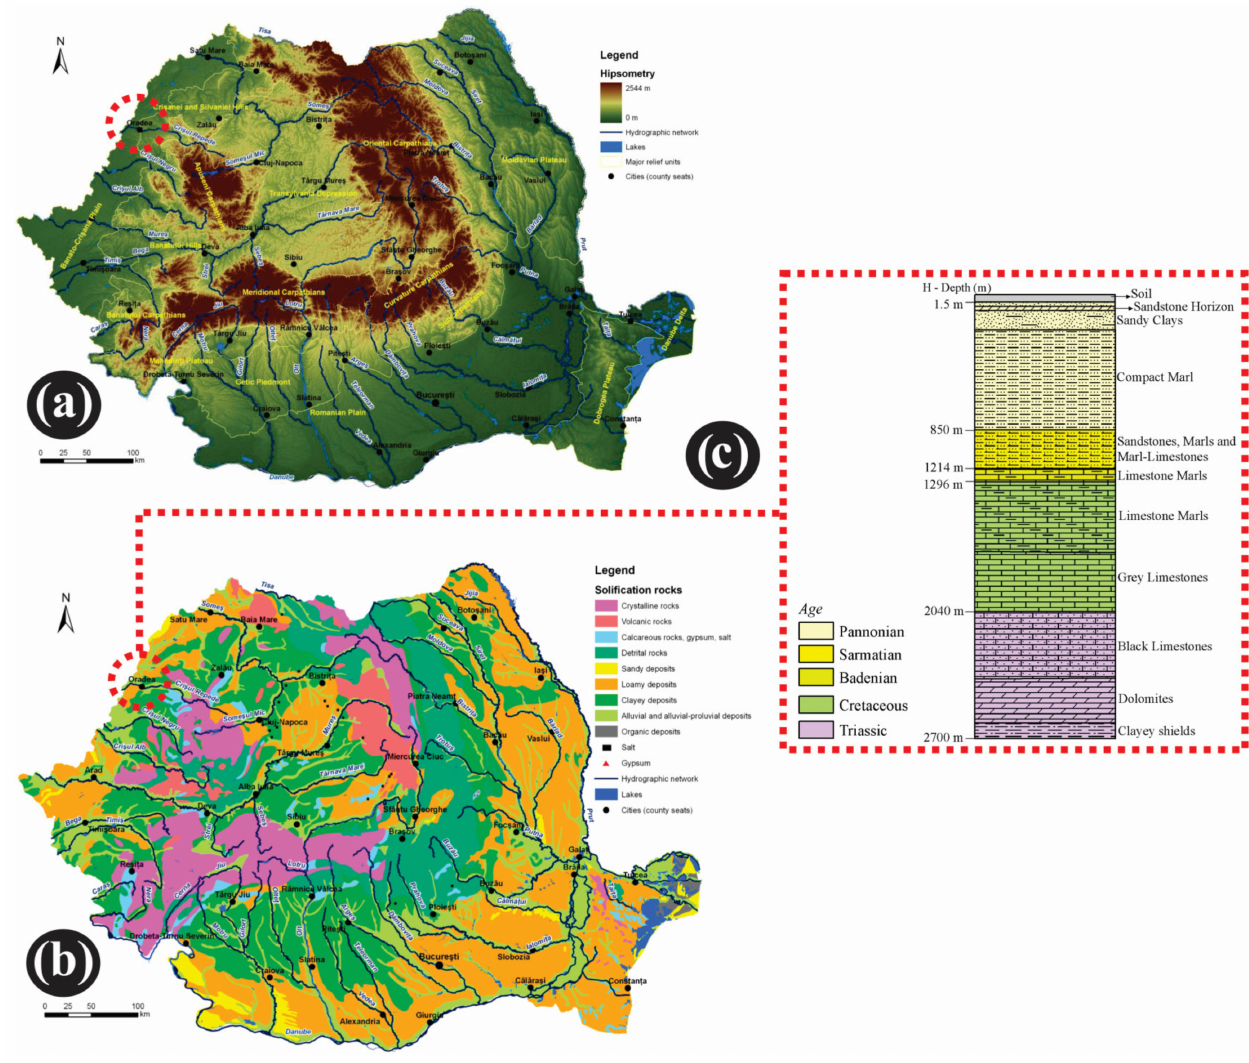
Figure 4. Major relief units ( a ), and solification rocks in Romania ( b ) with the Oradea area stratigraphic chart ( c ). Data source: modified after